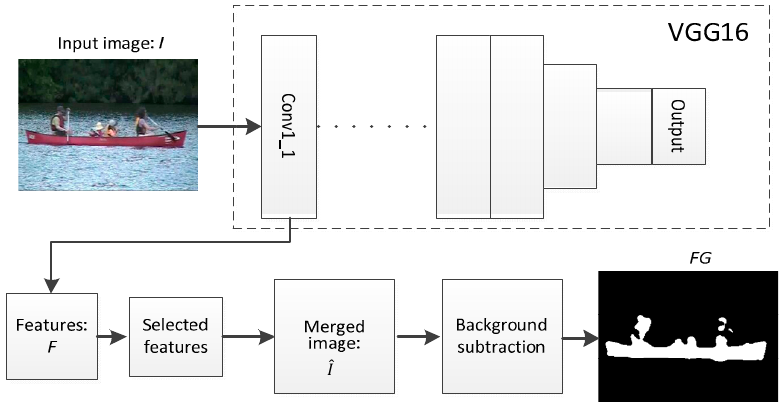
Figure 1. The framework of the proposed method.